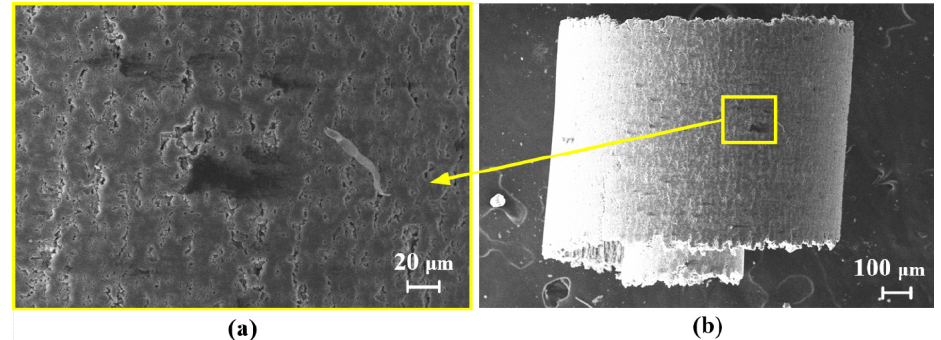
Figure 9. SEM image of chip surface machined by non-textured PCD tool. ( a ) Black trace on the chip surface; ( b) SEM image of chip surface machined by non-textured PCD tool.